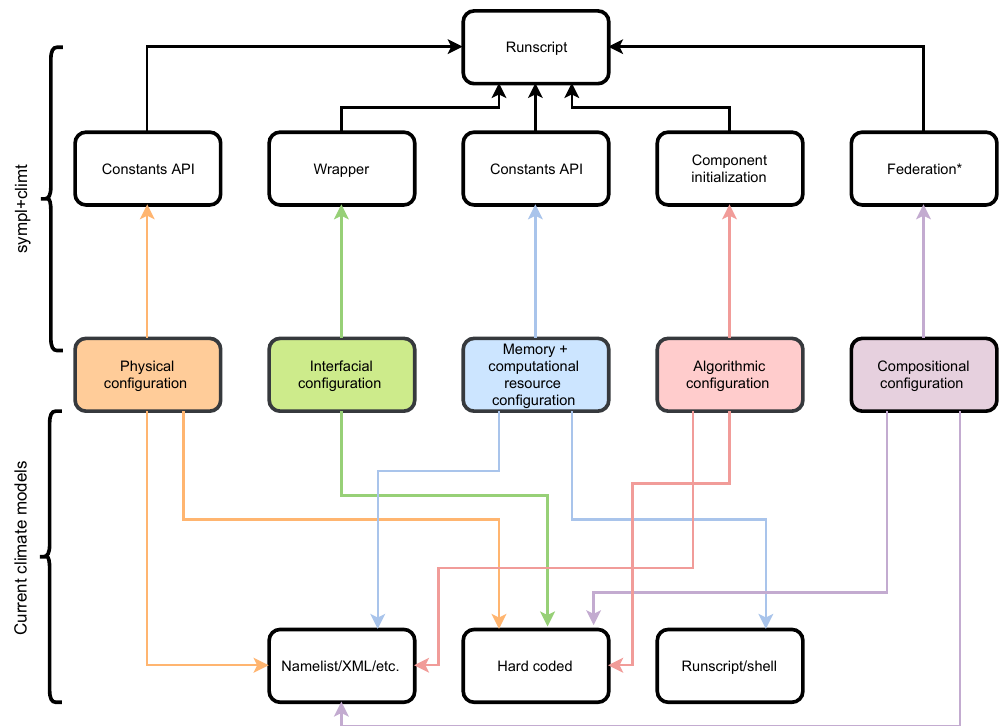
Figure 5. The variety of configuration options in a climate model and in the sympl − climt framework. The coloured boxes indicate the type of configuration and the white boxes parts of the model code base. Arrows from the coloured to the white boxes indicate the part of the code base that is typically responsible for the configuration from which the arrow originates. A particular type of configuration could exist in two different parts of the code base: such a situation is indicated by multiple arrows terminating at all the relevant white boxes. Note that not every climate model uses all configuration options. The starred box on the sympl + climt side indicates functionality that is not yet